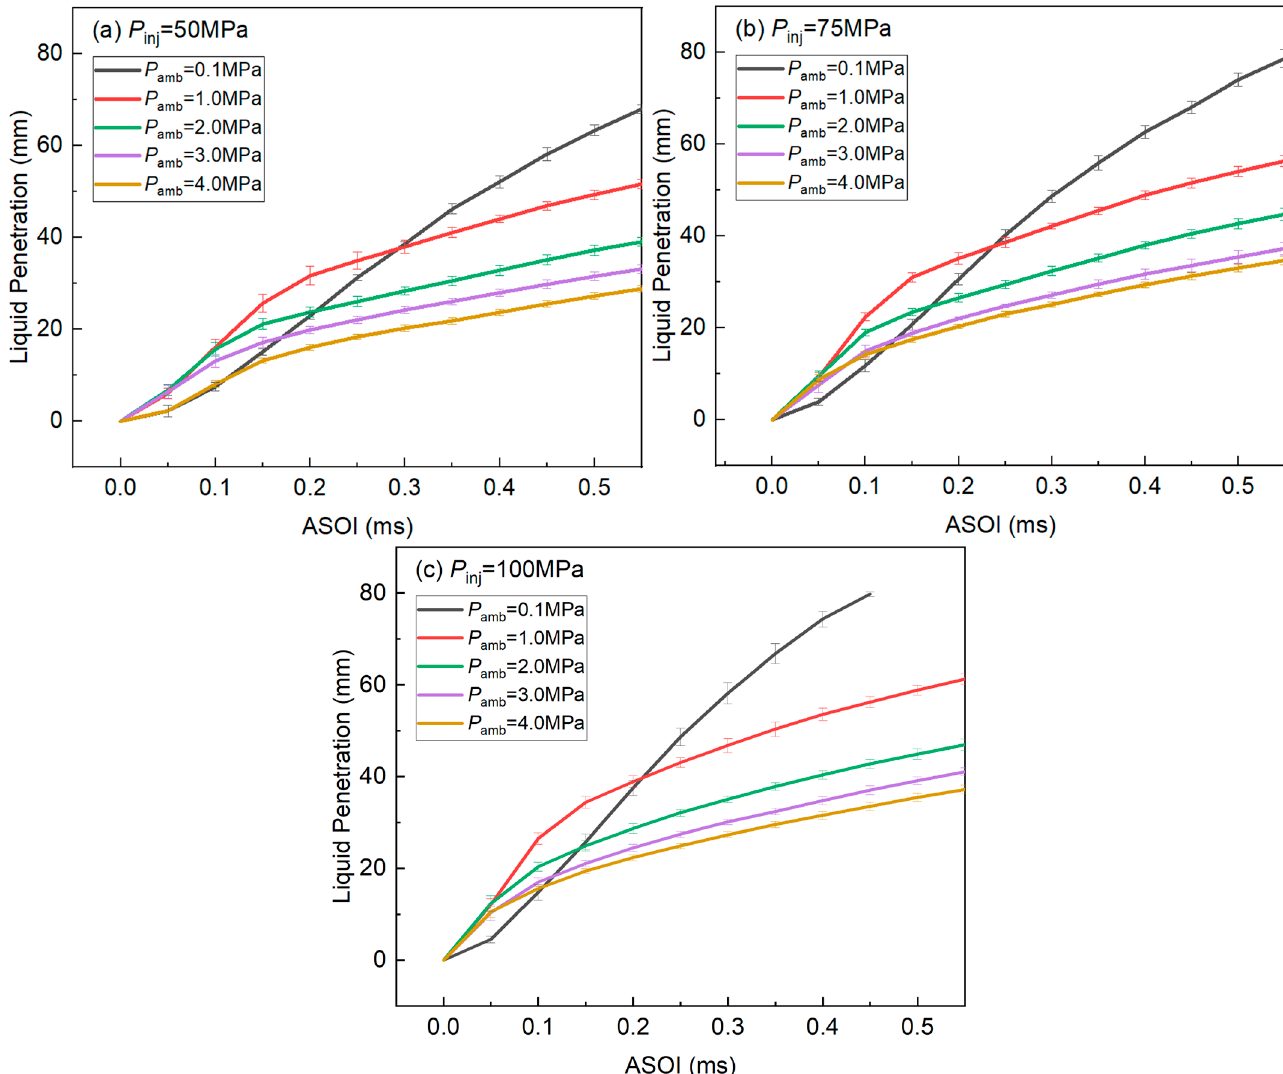
Figure 7. This resulted in better accuracy in terms of original time.